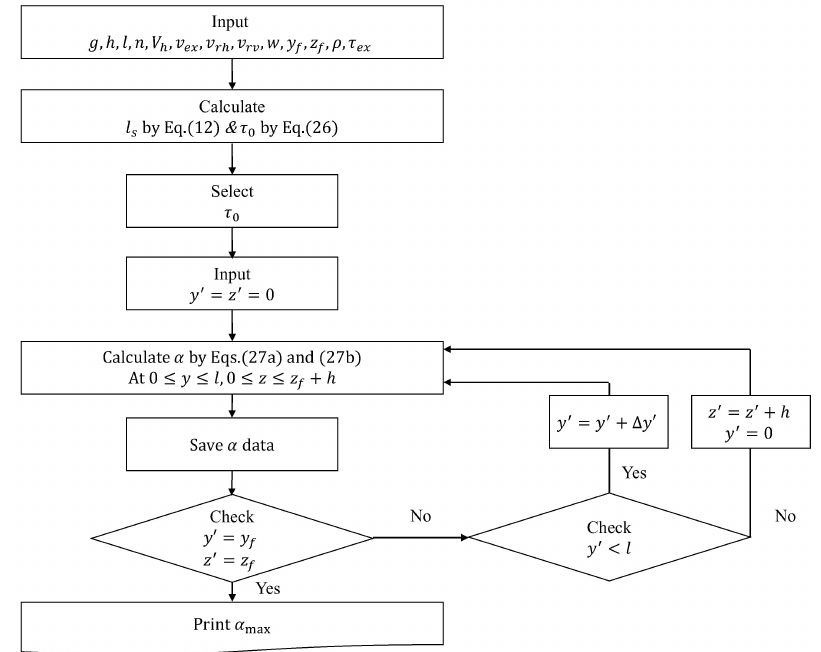
Figure 9. Computational procedures to calculate τ 0 , α max .